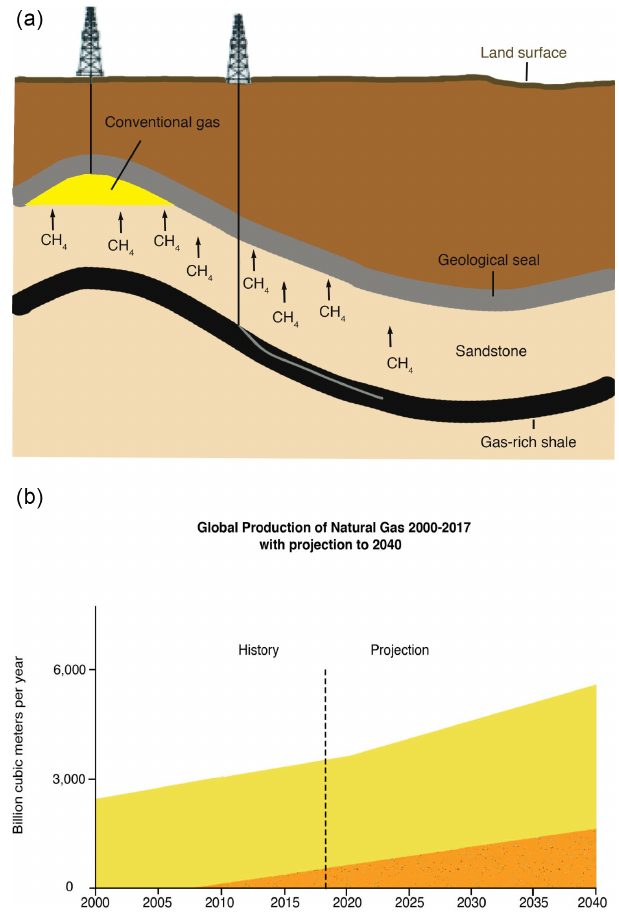
Figure 2. (a) Schematic comparing shale gas and conventional nat- ural gas. For conventional natural gas, methane migrates from the shale through semipermeable formations over geological time, be- coming trapped under a geological seal. Shale gas is methane that remained in the shale formation and is released through the com- bined technologies of high-precision directional drilling and high- volume hydraulic fracturing. (b) Global production of shale gas and other forms of natural gas from 2000 to 2017, with projections into the future from EIA (2016). Redrawn from EIA (2016) with data from IEA